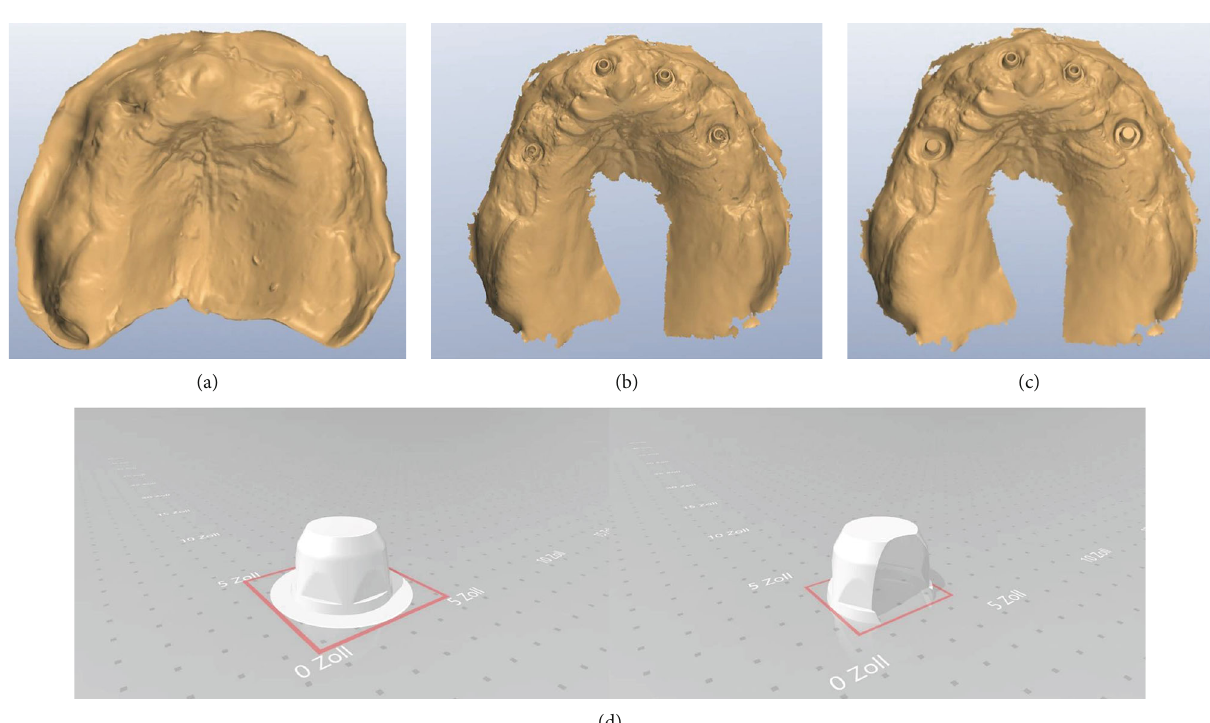
Figure 10: (a) Axial view of the modi fi ed upper jaw base initial scan. (b) Axial view of the scanned bar abutments. (c) Axial view of the matched scans. (d) For digital abutment check, the shape of the bar abutments stored in CAD